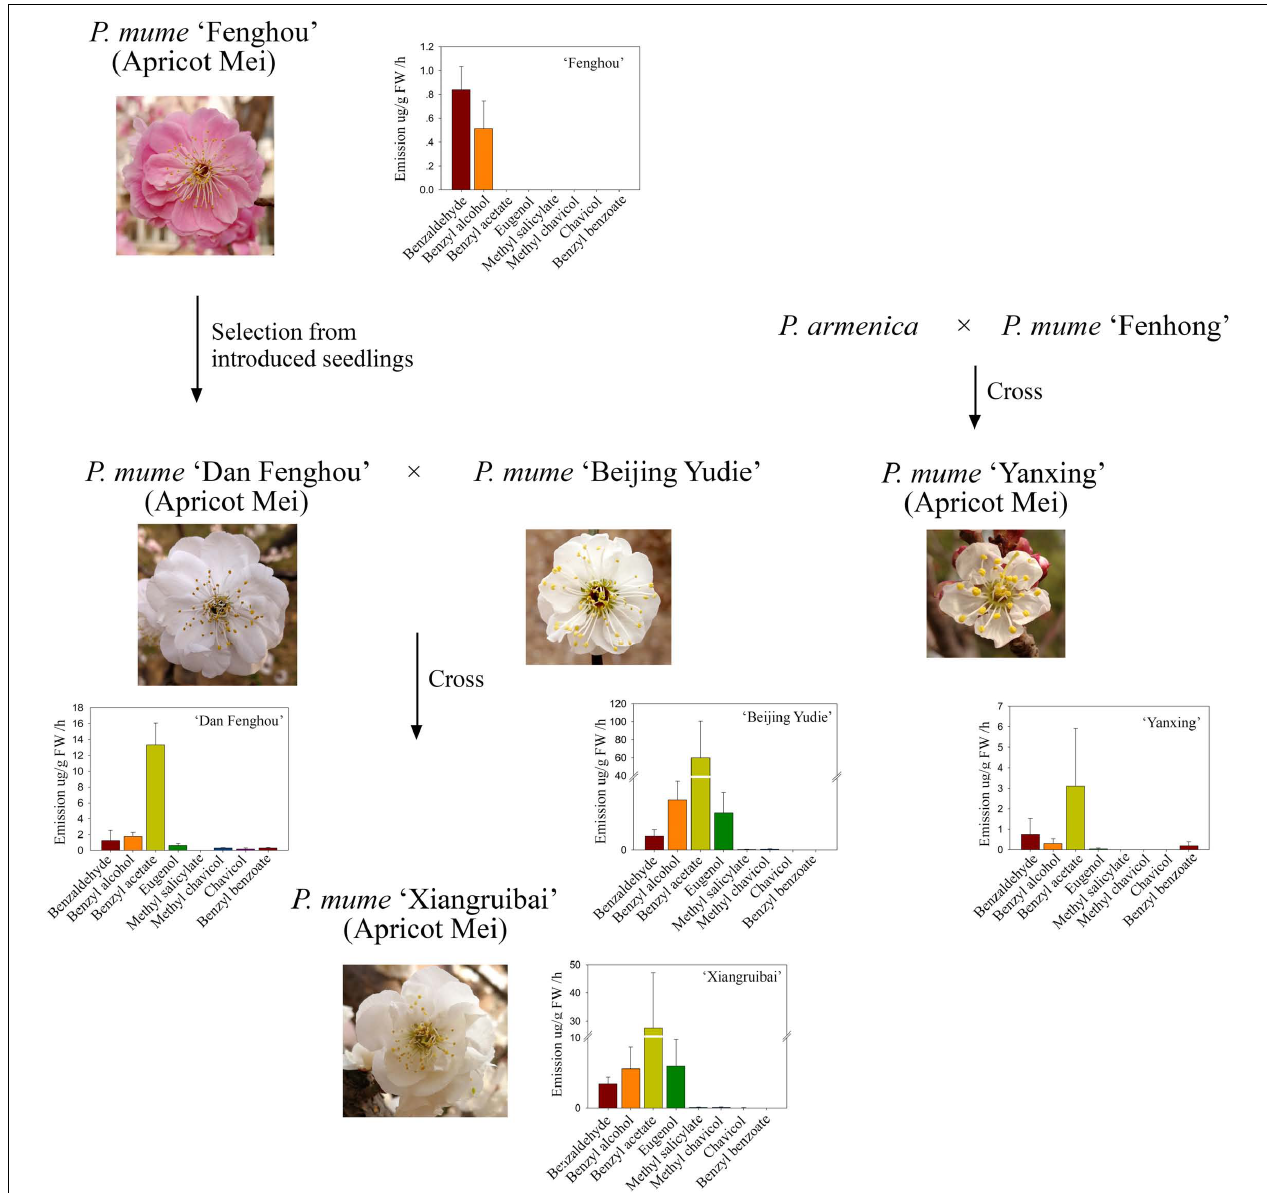
FIGURE 1 | Genetic relationships and floral scent metabolites among the five varieties. The family trees indicate the origins and genetic relationships of five P. mume varieties “Fenghou”, “Dan Fenghou”, “Beijing Yudie”, “Xiangruibai” and “Yanxing” The bar graphs indicate the floral scent components detected in the headspace of fresh flowers by HS-SPME-GC-MS. The values on the graphs are presented as the mean values of three biological replicates ±